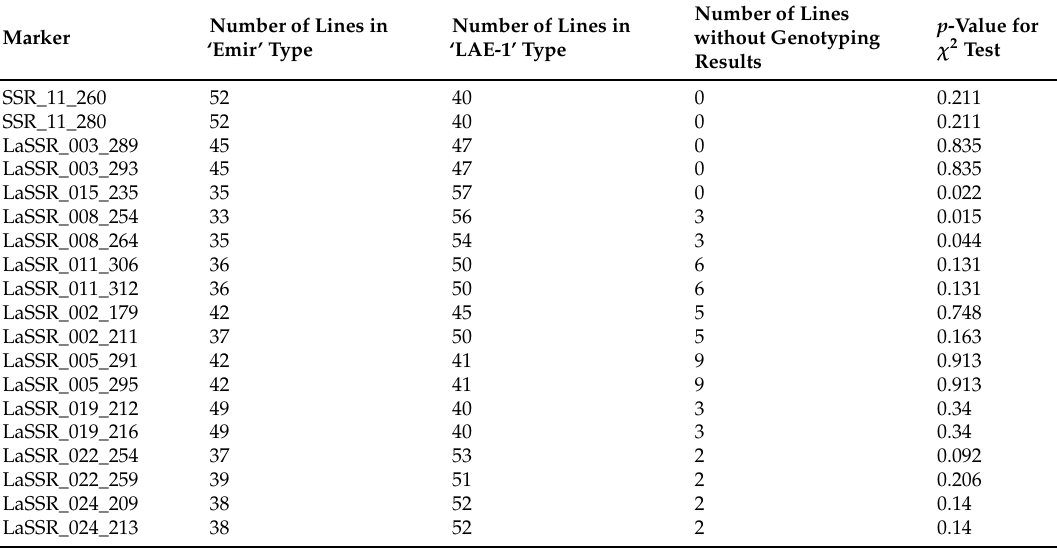
Table 2. Results of genotyping RIL mapping population EL with SSR